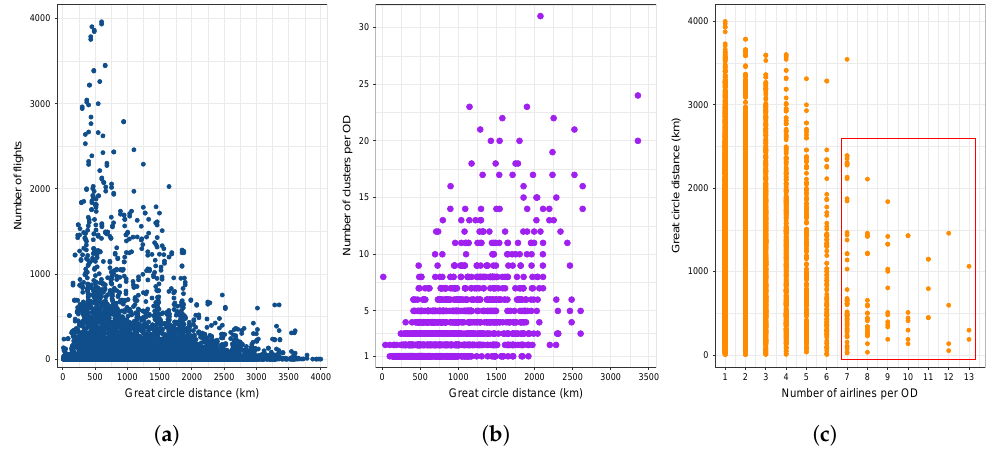
Figure 4. Relation between the GCD between ODs and number of flights, number of clusters and number of airlines. ( a ) GCD vs. number of flights; ( b ) GCD vs. number of clusters; ( c ) GCD vs. number of airlines.